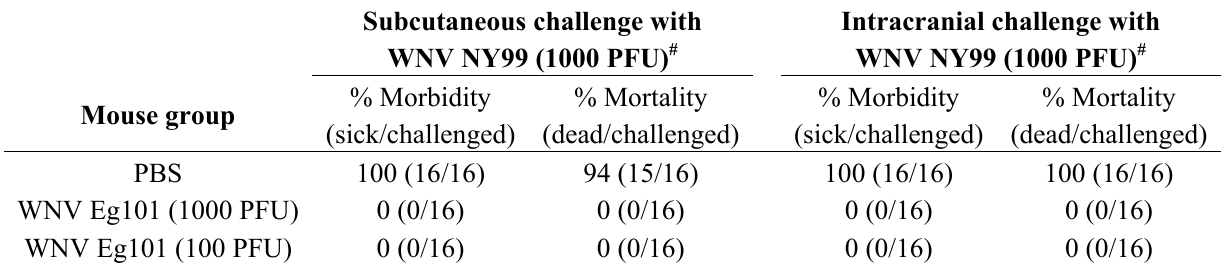
Table 1. Protection of immunized mice from lethal challenge with WNV